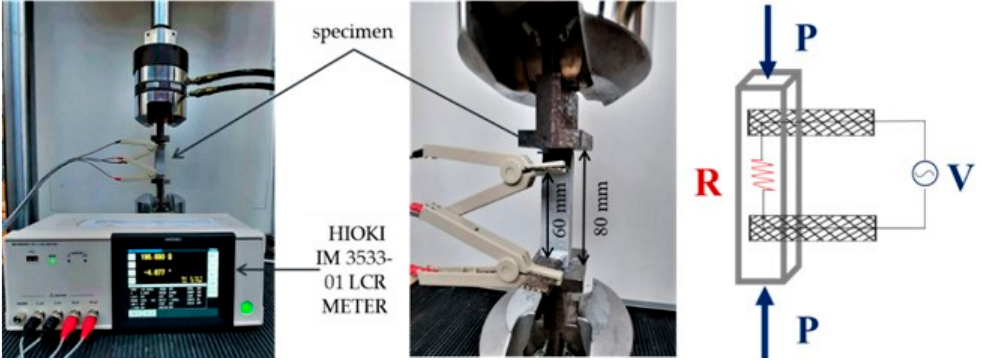
Figure 3. The test setup and instrumentations for the piezoresistivity measurements.